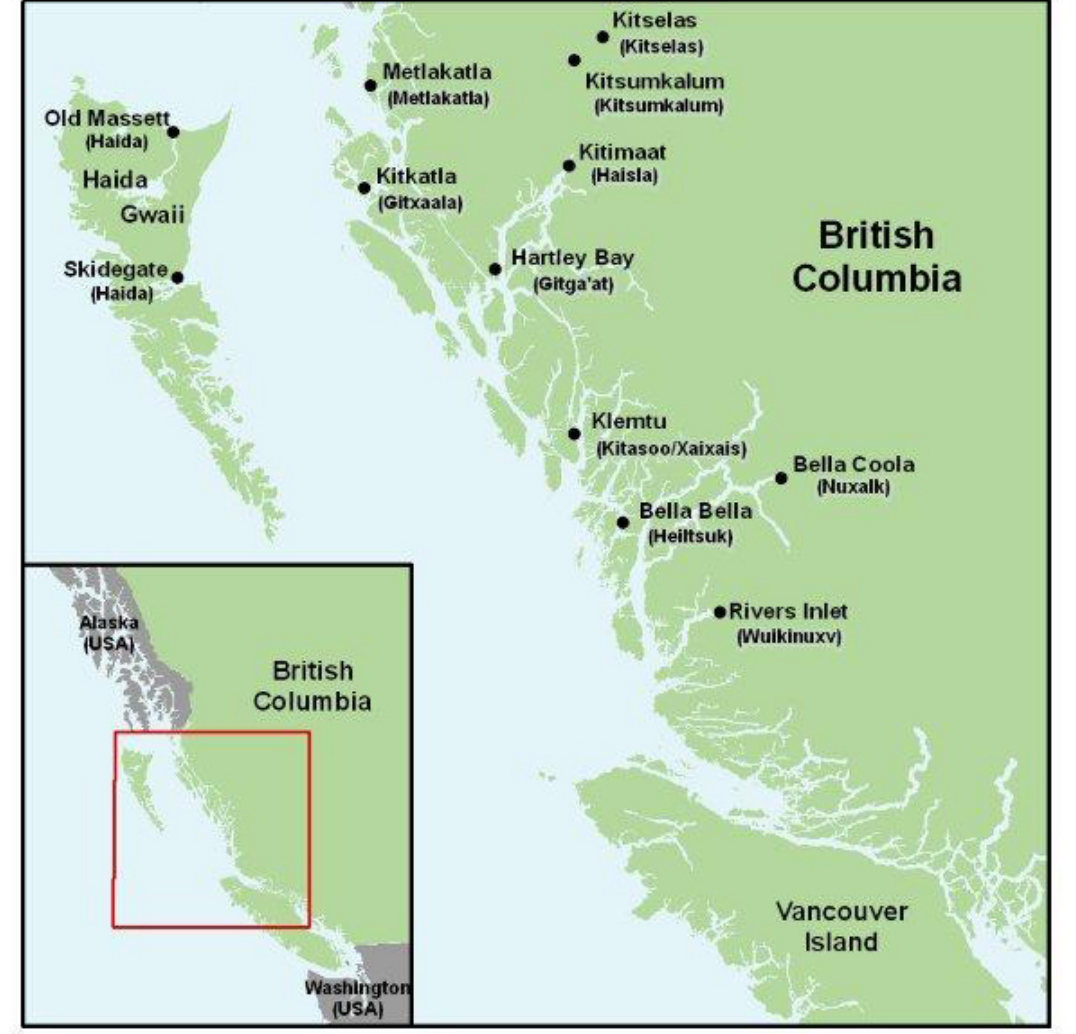
Fig. 1 . British Columbia First Nation communities, including the Haida, involved in